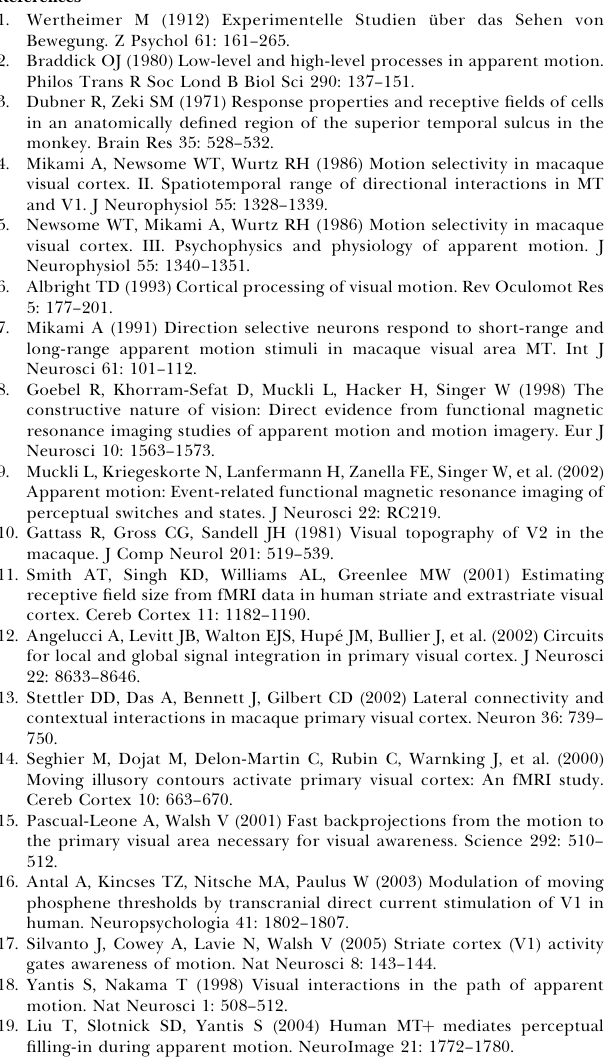
Figure S3. Group Results from Bistable Motion Quartet (Experiment 3) Results of experiment 3 are shown on medio-posterior views of the inflated left occipital cortex of all six subjects ([A and B] LM, HP, and AK; [C and D] VV, MW, and MN). Color coding for subjects LM, VV, MW, and MN is identical to the coding for HP and AK described in Figure 6. (A and C) Activation maps show the cortical representation of the stimulated locations in red (motion quartet . baseline). Contrast maps in green indicate regions that are more active for vertical apparent motion than for horizontal apparent motion (ROI-based GLM at locations indicated by the white line—LM: t [708] . 3.3, p , 0.001; HP: t [301] . 2.5, p , 0.02; AK: t [708] . 2.0, p , 0.05; VV: t